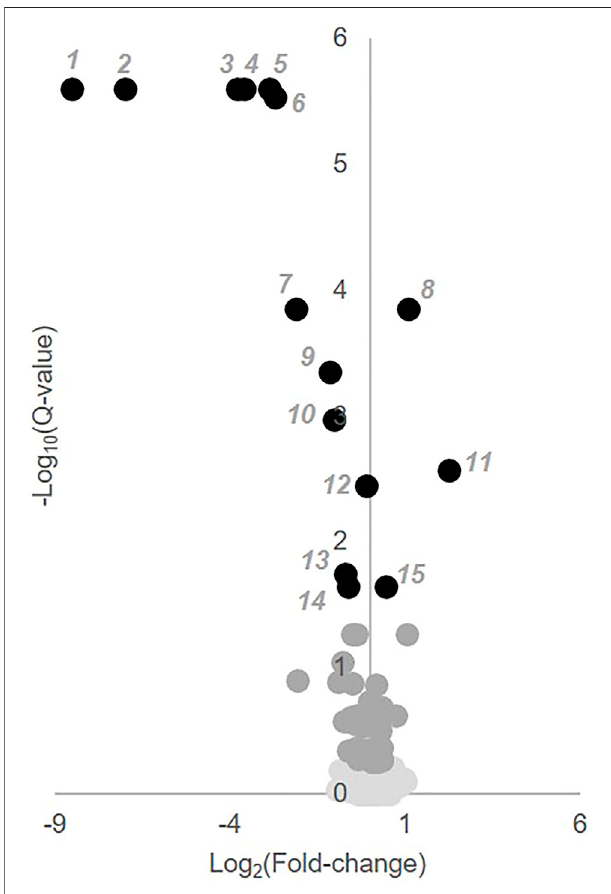
FIGURE 2 | Identi fi cation of key metabolites altered following the initiation of MTX. Semi-quantitative data from 673 identi fi ed metabolites measured at baseline and after 3 months of MTX therapy were compared by paired univariate analysis. Metabolomics data was analyzed using MetaboAnalyst 3.0and the resulting volcano plotofkeymetabolites based on a q-value < 0.05 are presented. In the volcano plot, black numbered metabolites represent thosefound tobe altered